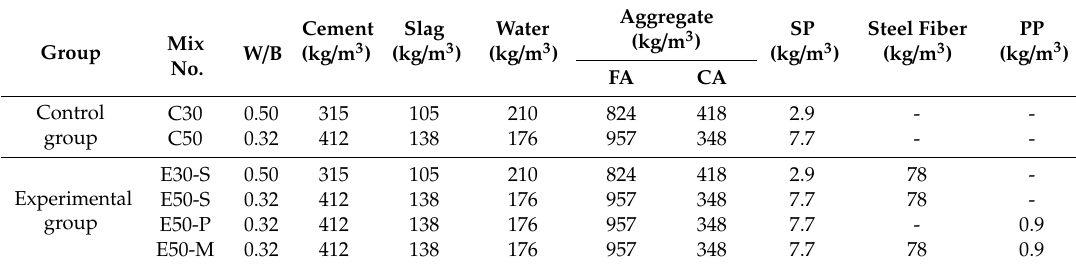
Table 5. Concrete mix design